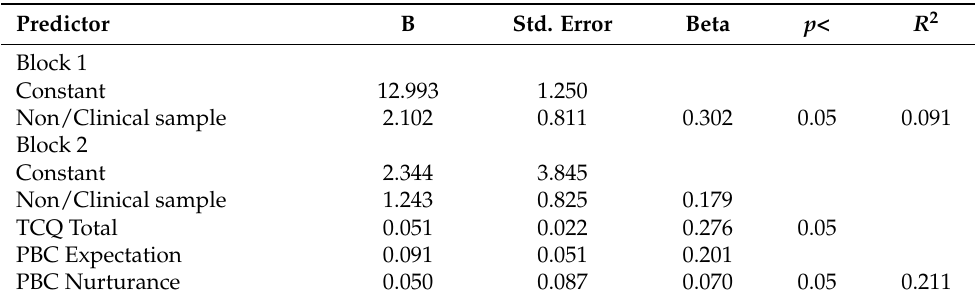
Table 3. Multiple Regression Statistics: Model